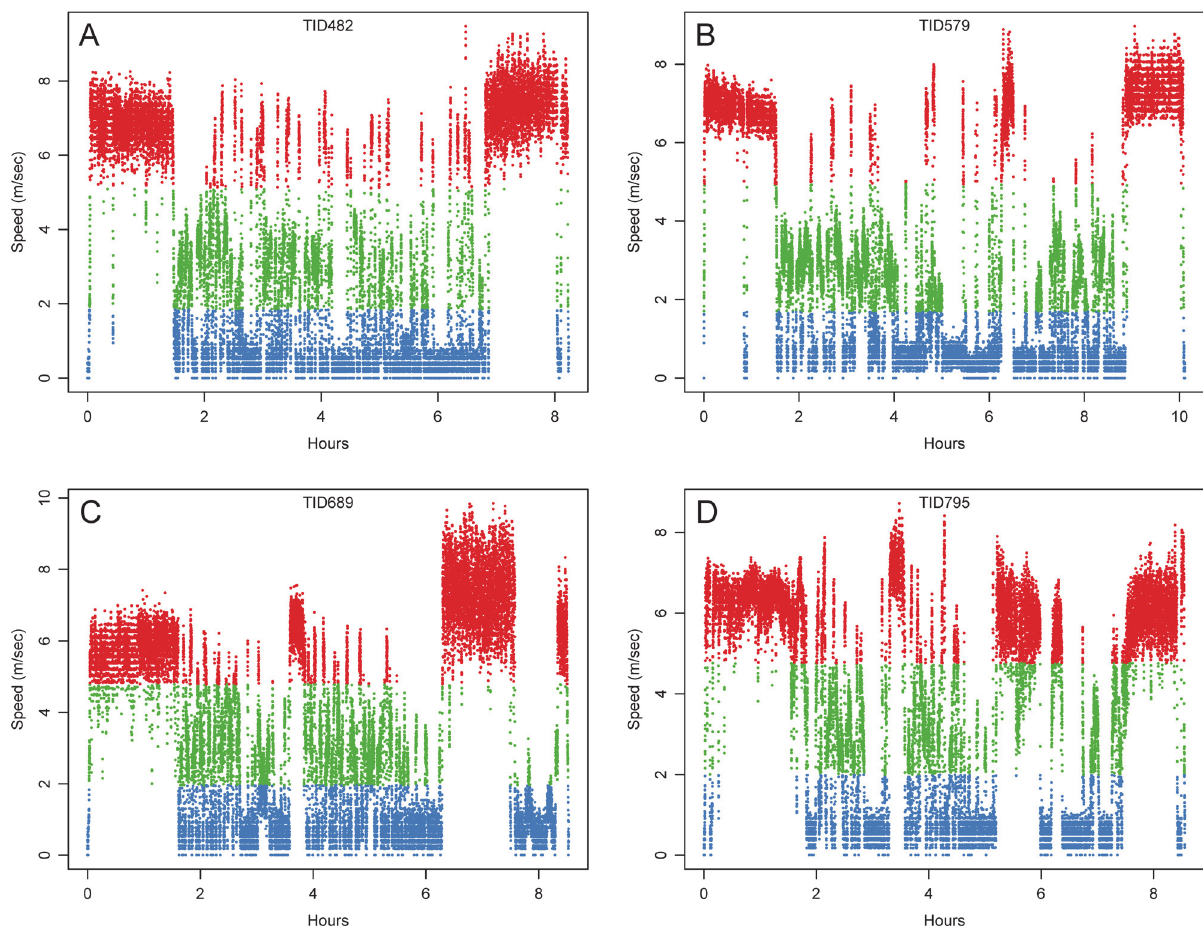
Fig 3. Plot of speed versus time for FAD fishing trips. Plots show the four trips in Fig. 2. Points are color coded in the same way. Periods of travel are fairly homogenous, while behaviors at patches show